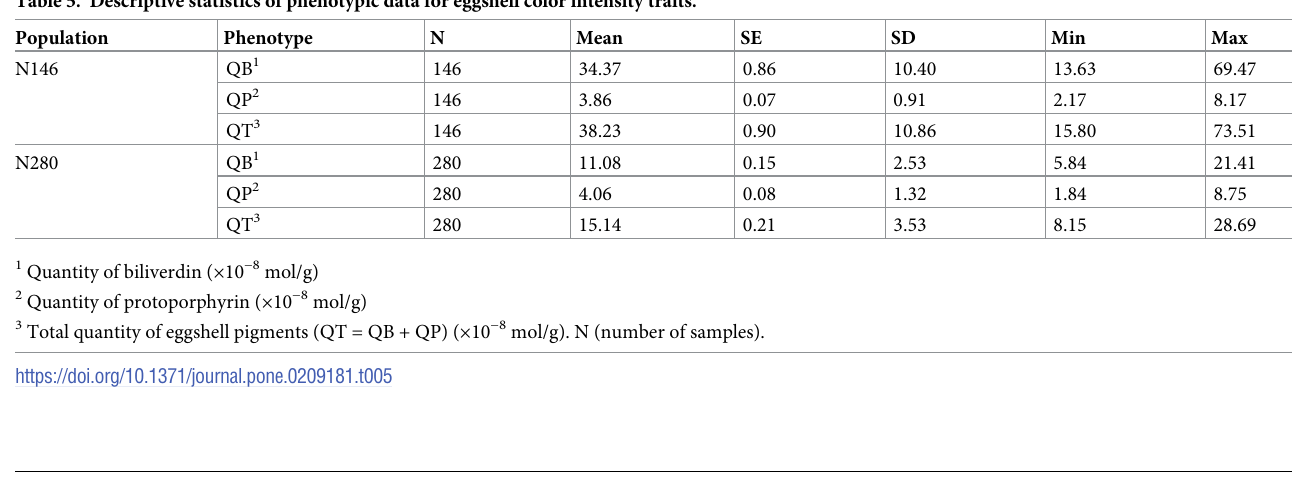
and SNP rs16177126 than were those with the homozygous GG or heterozygous GA genotype. At locus rs16177219 the homozygous GG was associated with higher QB and QT than were the genotypes GT and TT (P < 0.05), whilst, the homozygous GG at SNP rs16177212 was asso- ciated with higher QB and QT than were GA and AA genotype (P < 0.05) (Table 6). For N280 population, statistical analysis showed that out of ten SNPs, two SNPs (rs16177219 and rs16177126) were significantly associated with QB and QT traits. Polymor- phism rs315477097 was strongly associated with QB, QP and QT traits, while Polymorphism rs13602462 was significantly correlated with the 3 phenotype traits. SNP rs315586328 and rs313199923 were strongly associated with QB (P < 0.01) and significantly with QT, while SNP rs16177212 significantly related only to QP (P < 0.05) (Table 7). At locus rs315477097, individuals with the homozygous GG associated with higher QB, QP, and QT. The homozy- gous genotype CC at locus rs13602462 was associated with higher QB and QT, while genotype CT associated with higher QP. At locus rs315586328 genotype AA associated with higher QB and QT whereas genotype TT in polymorphism rs313199923 associated with higher levels of both traits. Interestingly, two mutual SNP loci (rs16177219 and rs16177126) were discovered between this population and N146 population in which the same homozygous genotype GG and AA were significantly associated with increased levels of QB and QT in both of the two